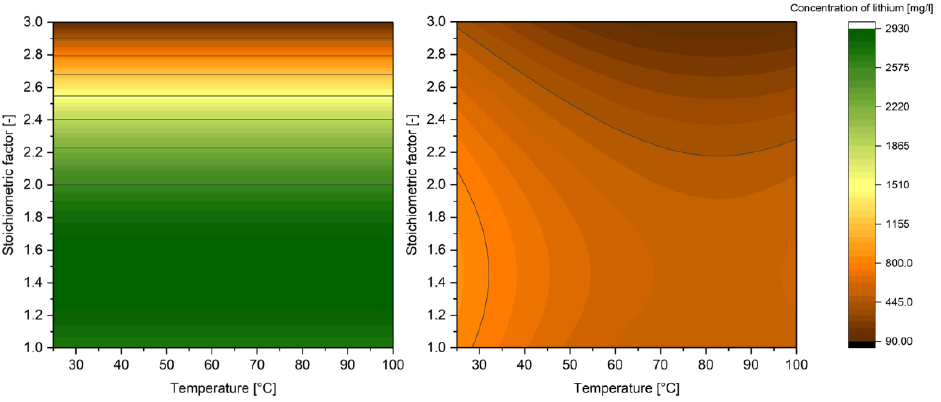
Figure 4. Statistical evaluation of the dissolved residual concentrations in mg · L − 1 of lithium starting from the synthetic ( left , 10,000 mg · L − 1 ) and authentic ( right , 5000 mg · L − 1 ) leaching solution using the precipitant Na 3 PO 4 as a function of temperature and the stoichiometric factor of the precipitant.